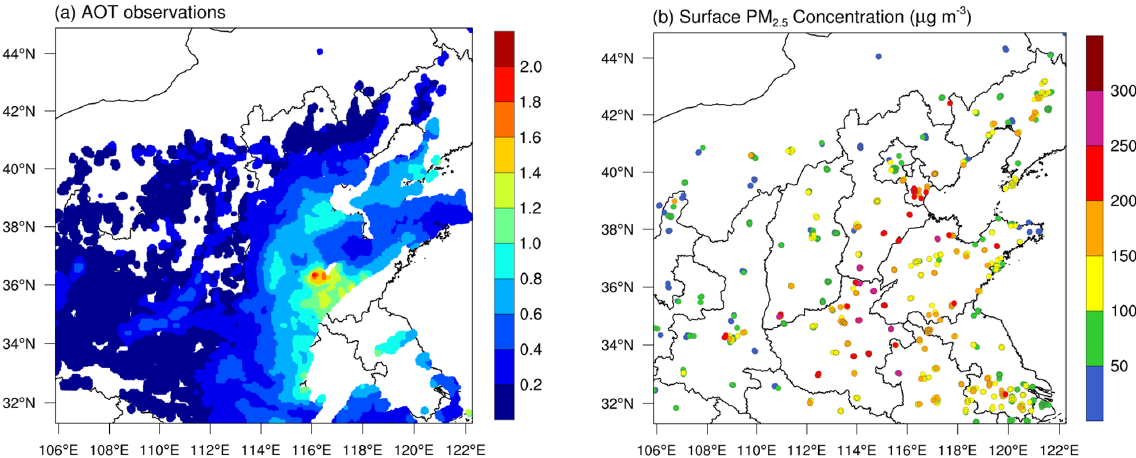
Figure 3. Observations of the thinned Himawari-8 AOTs (a) and surface PM 2 . 5 mass concentration (b) in D02 at 03:00UTC on 25 November